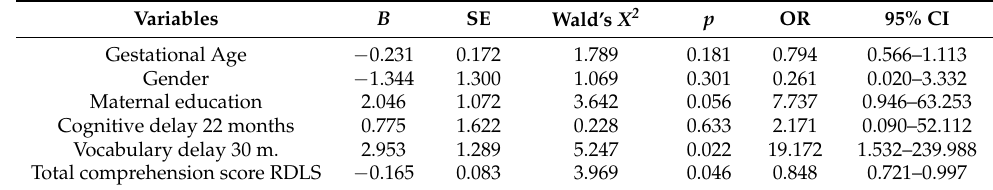
Table 8. Logistic regression analysis: predictors of vocabulary comprehension delay (PPVT-III) at 60 months of age.